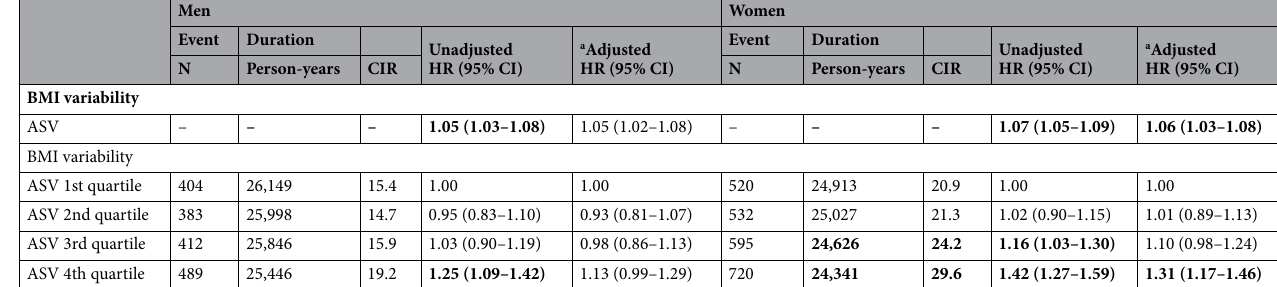
Table 3. Risk of Alzheimer’s disease according to BMI variability. BMI body mass index, ASV average successive variability, CIR cumulative incidence rate, HR hazard ratio, CI confidence interval. a Adjusted for